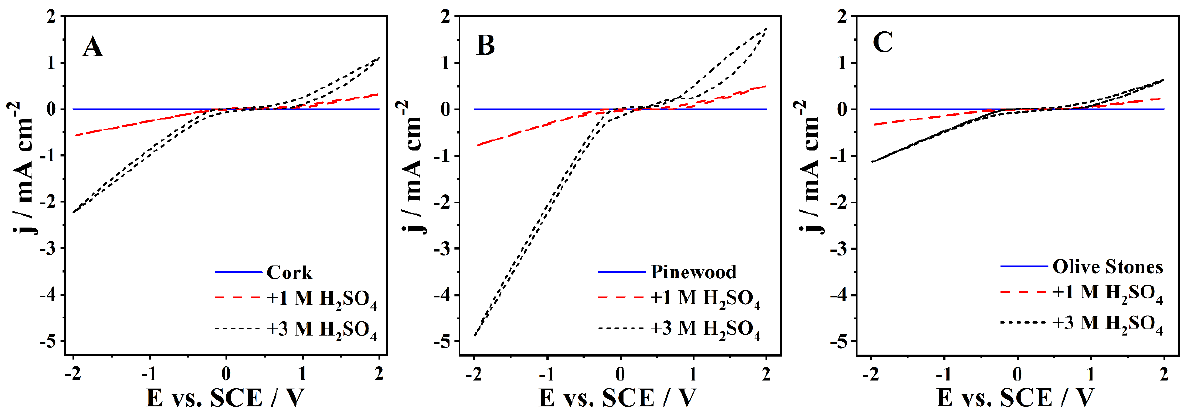
Figure 2. The CVs of the ( A ) cork bio-oil, ( B ) pinewood bio-oil, and ( C ) olive stones bio-oil samples, performed with a Pt electrode at 50 mV s − 1 .